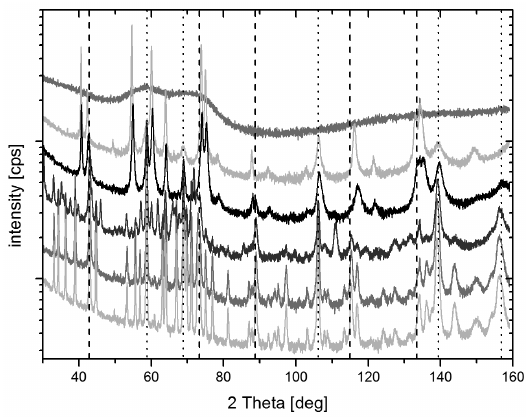
Ni Si alloy in as-cast state, and 75 10 20